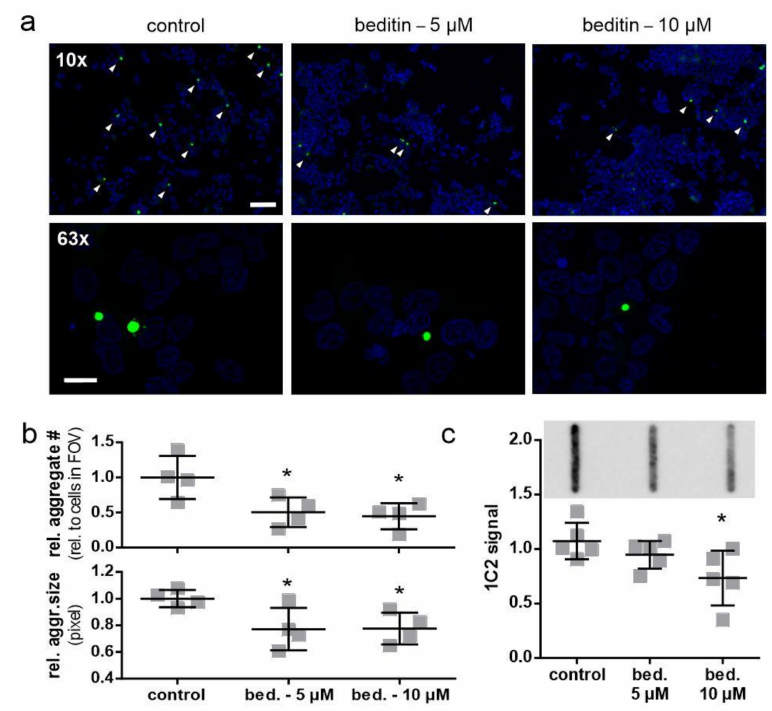
Figure 6. Beditin reduces mHTT exon 1 aggregation in a transient overexpression model. ( a ) Fluo- rescent imaging of HTT exon 1 49Q overexpression in human embryonic kidney (HEK) 293T cells for 24 h, with beditin (bed.) 5 µ M and 10 µ M treatment at 10 × magnification (scale bar: 100 µ m) for determination of aggregate count and 63 × (scale bar: 20 µ m) for determination of aggregate size. Aggregates at 10 × magnification are highlighted by white arrow heads. ( b ) Quantification of aggregate count per cells in field of view (FOV) (top panel) and quantification of aggregate size (bottom panel). One-way ANOVA with multiple comparisons against control and Dunnett’s multiple comparison correction. Aggregate number: * p = 0.031 (5 µ M) and * p = 0.018 (10 µ M); n = 4. Aggre- gate size: * p = 0.044 (5 µ M) and * p = 0.048 (10 µ M); n = 4. ( c ) Filter trap analysis of HTT exon 1 49Q overexpression in HEK293T cells for 24 h with beditin 5 µ M and 10 µ M treatment. A representative image of filter trap immunodetection is shown above the respective quantification. One-way ANOVA with multiple comparisons against control and Dunnett’s multiple comparison correction. * p = 0.027 (10 µ M); n =